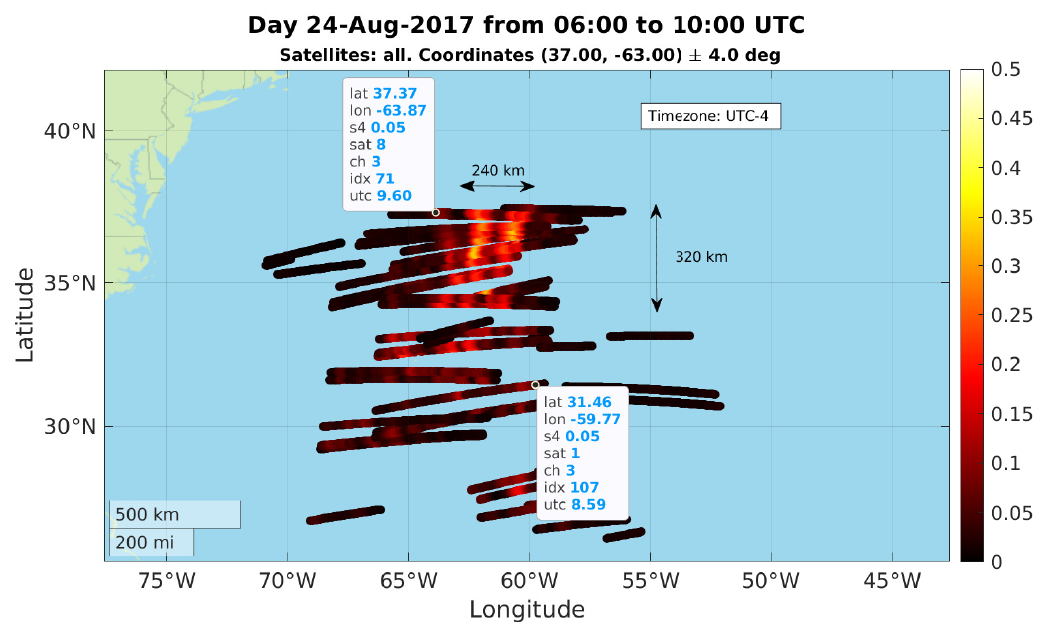
Figure 11. Peak in S 4 value in Western part of North Atlantic on 24 August 2017.